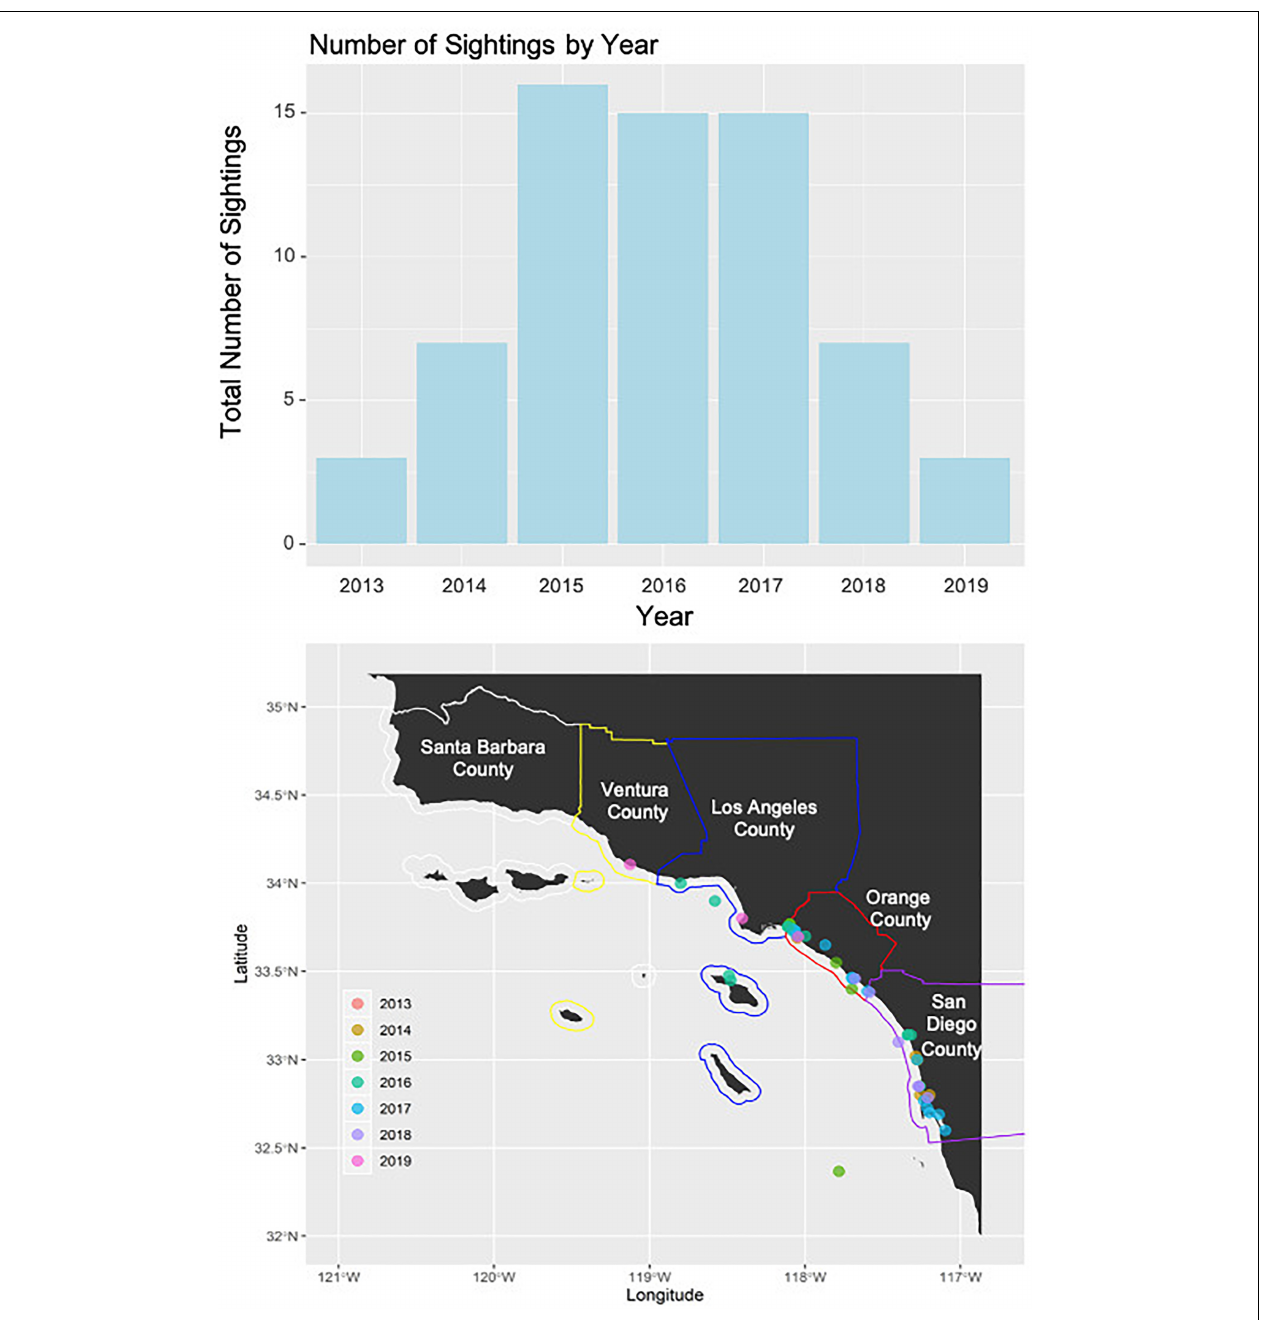
FIGURE 8 | The top panel displays the total overall number of green turtle reported from the NOAA sea turtle sightings hotline separated by year. The bottom panel displays the county borders (white = Santa Barbara, yellow = Ventura, blue = Los Angeles, red = Orange County, and purple = San Diego) on the southern California coastline with sightings reported by year in different